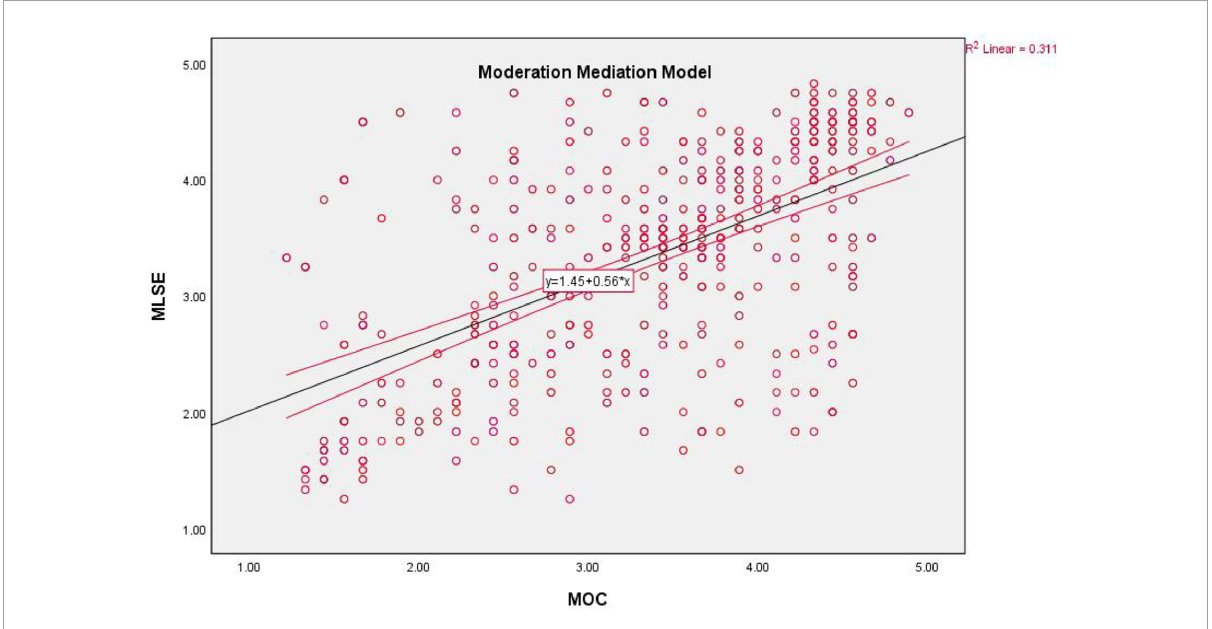
FIGURE4 Graphical representation of moderated mediation